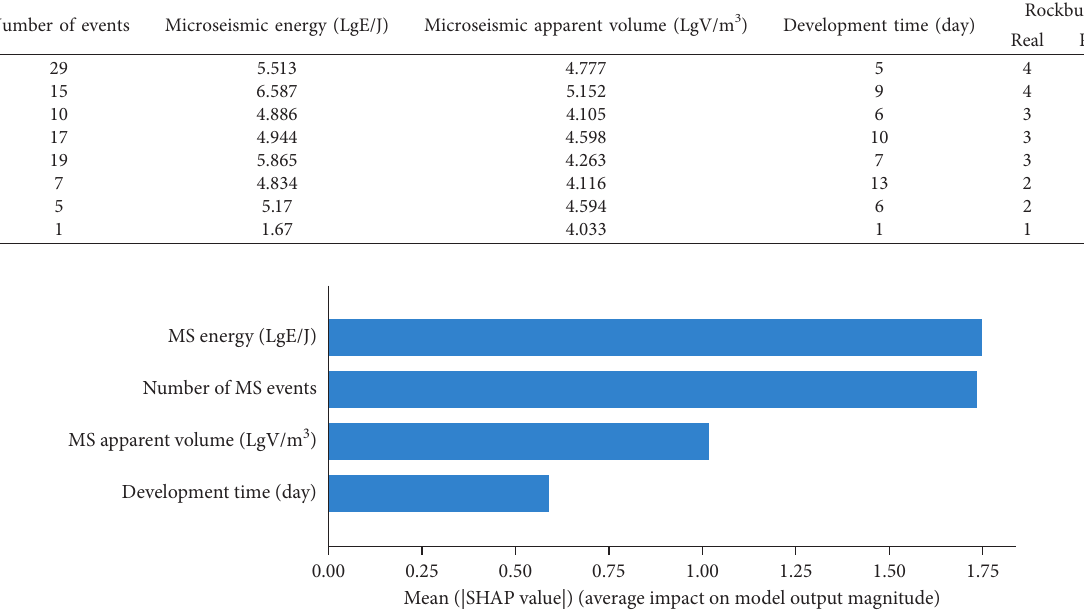
Figure 5: The important feature order of microseismic parameters based on